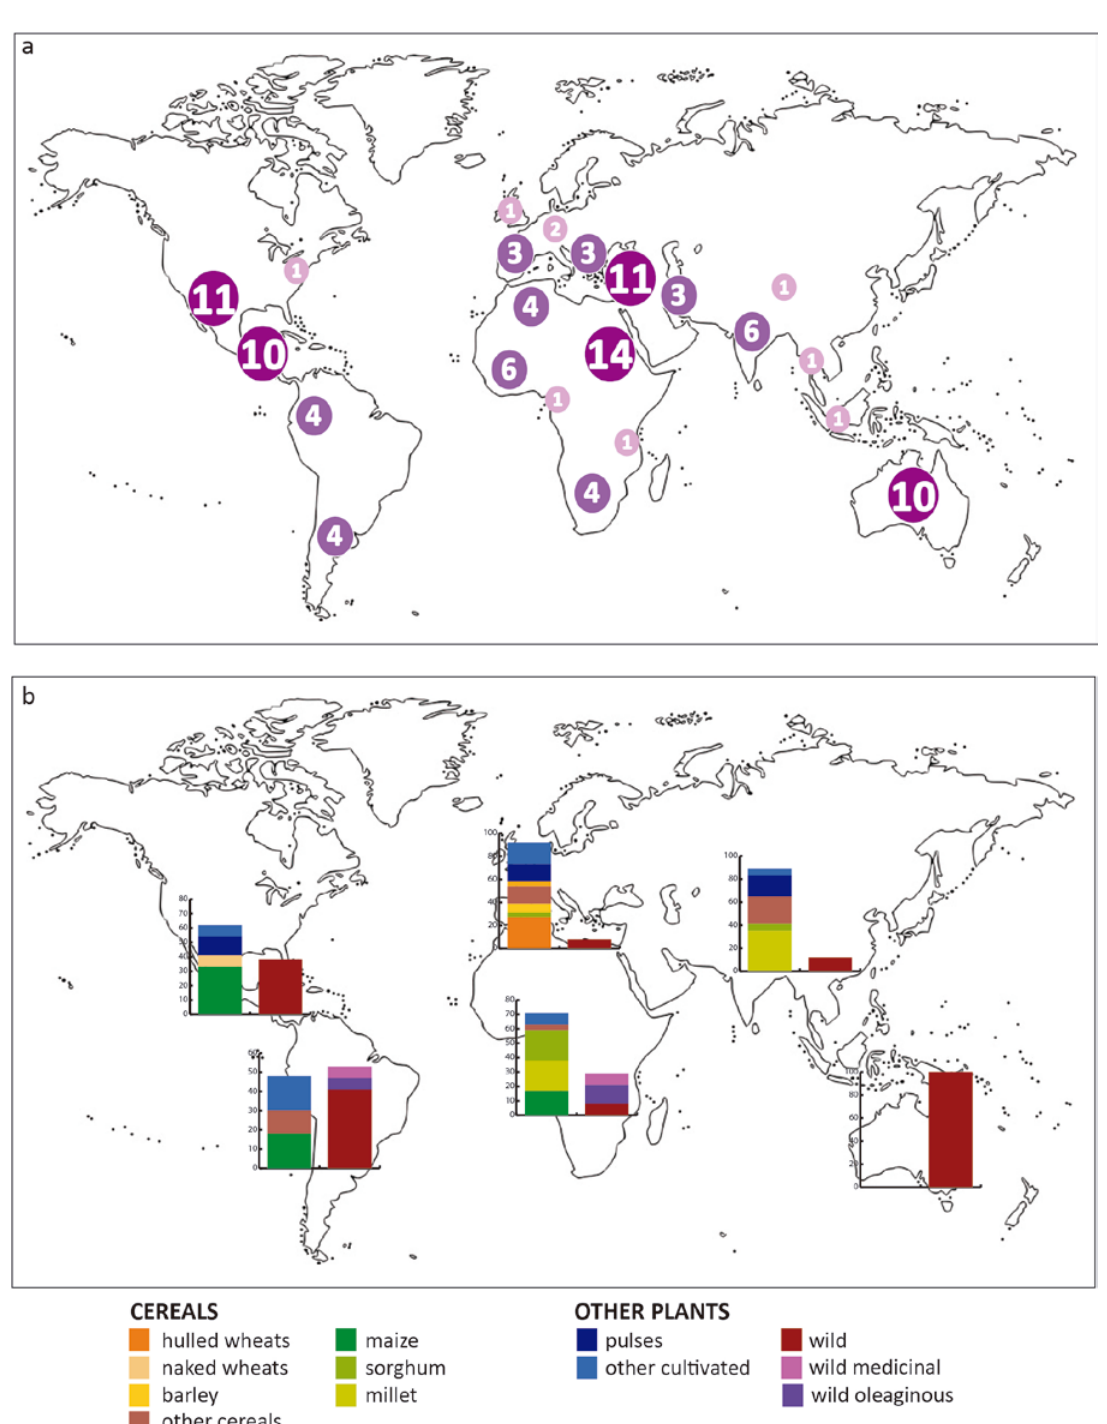
Figure 10. (a) Geographic zones with published ethnographic and ethnoarchaeologic studies that include data about grinding systems and their percentage (in the current state of the databse); (b) Percentage of citings of types of plants in the publications consulted to date in the following zones: southeast of North America and Meso America; South America; Europe and Mediterranean countries (plus Ethiopía); central and oriental Asia;